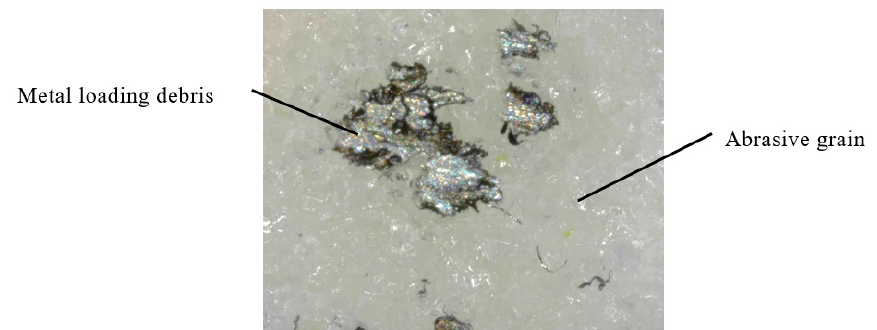
Figure 6. Original captured image of grinding wheel surface.